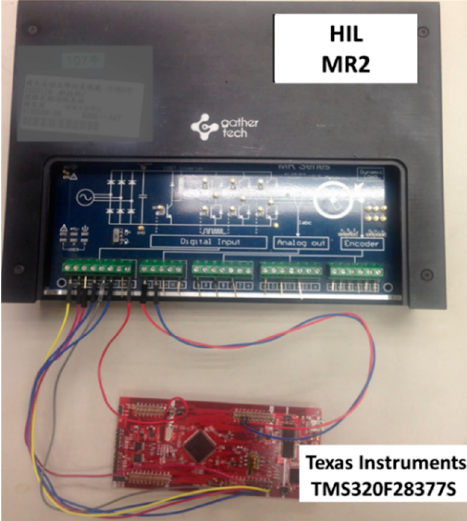
Figure 21. Hardware-in-the-loop (HIL) test setup and microcontroller. The Model is called MR2 [22,23]